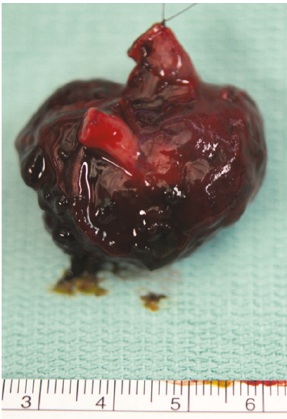
Figure 2: Intraoperative photograph showing the tumorous spher- ical structure (3 × 2cm) of the distal jejunum.